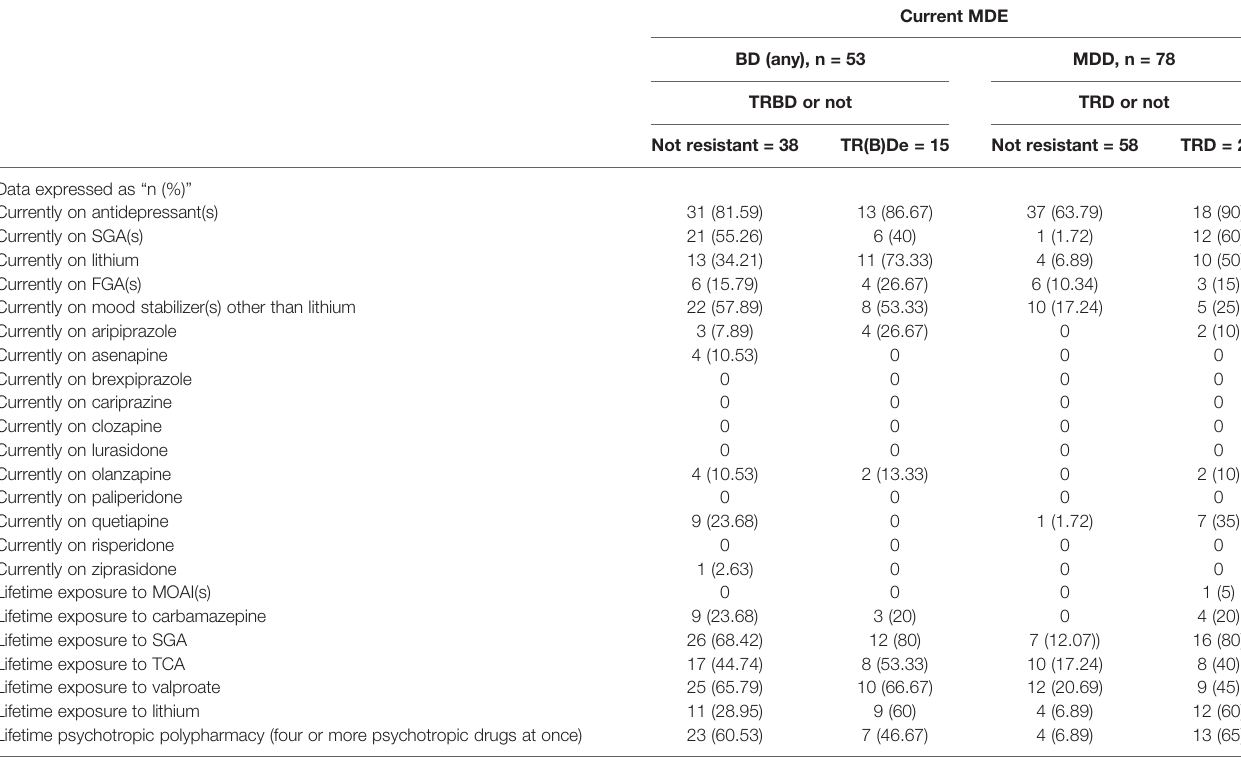
Current MDE BD (any), n = 53 MDD, n = 78 TRBD or not TRD or not Not resistant = 38 TR(B)De = 15 Not resistant = 58 TRD = 20